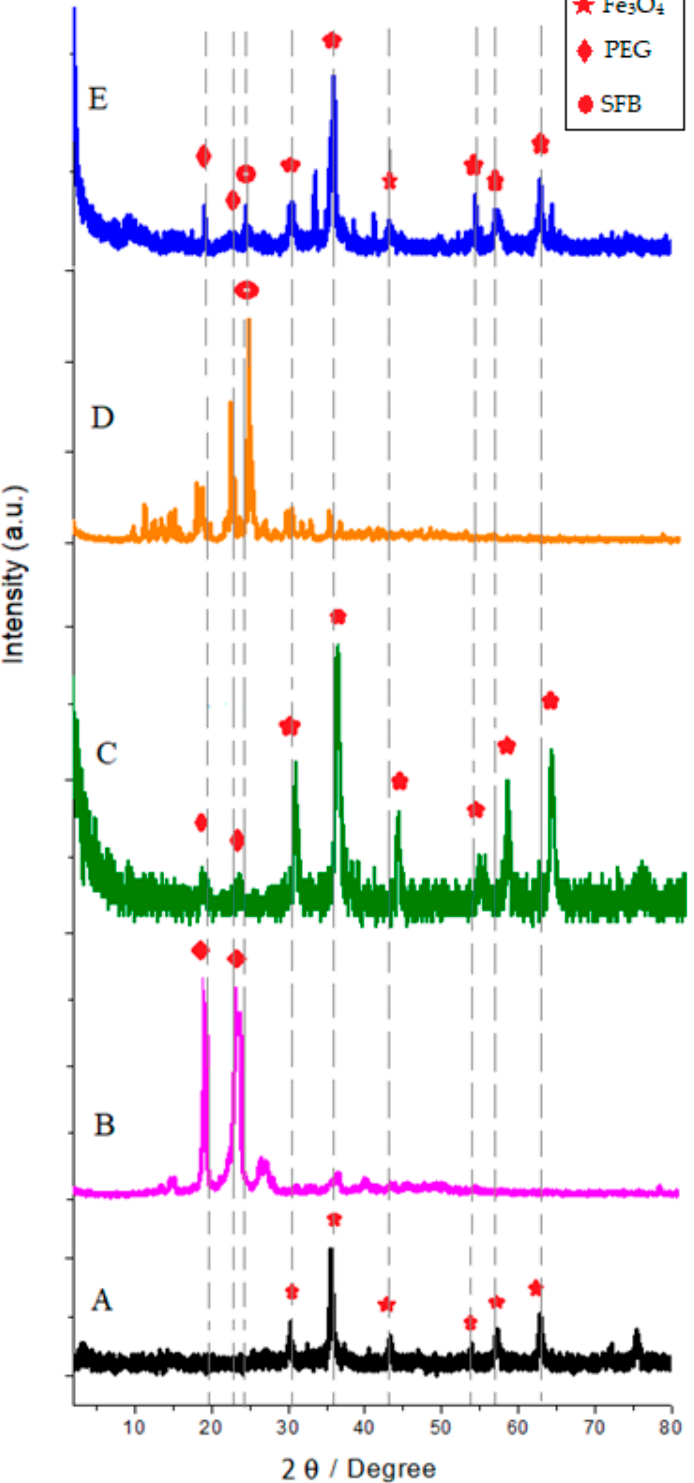
Figure 1. XRD of powdered ( A ) Fe 3 O 4 nanoparticles; ( B ) pure PEG; ( C ) Fe 3 O 4 @PEG; ( D ) SFB, ( E ) Fe 3 O 4